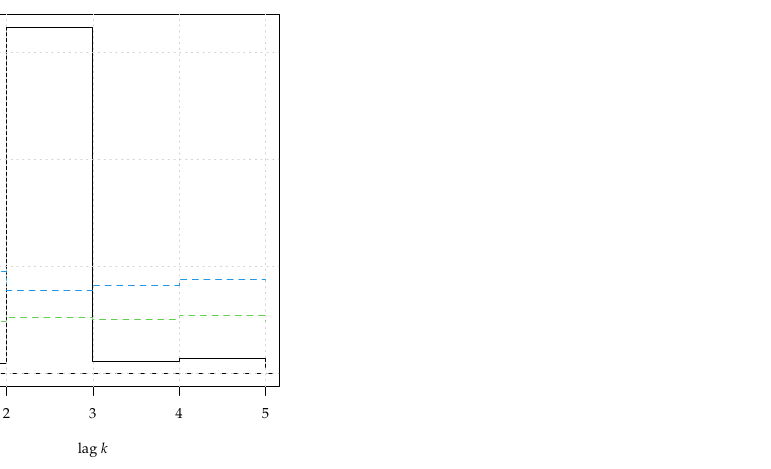
Figure 8. Serial Entropy S k for k = 1, . . . ,5 (black, solid line) computed on a correlated binary time series generated from discretizing a MA(2) process. The rejection bands at 95% (green dashed line) and 99% (blue dashed line) correspond to the null hypothesis of serial